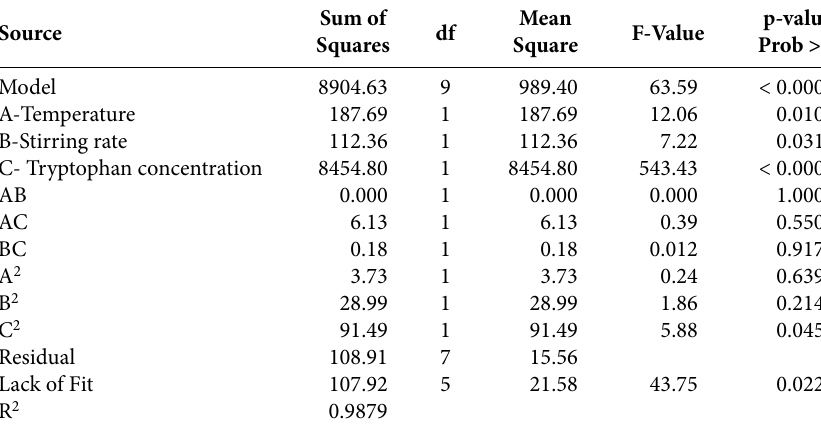
Table 5. ANOVA results of the quadratic model for vaterite content.